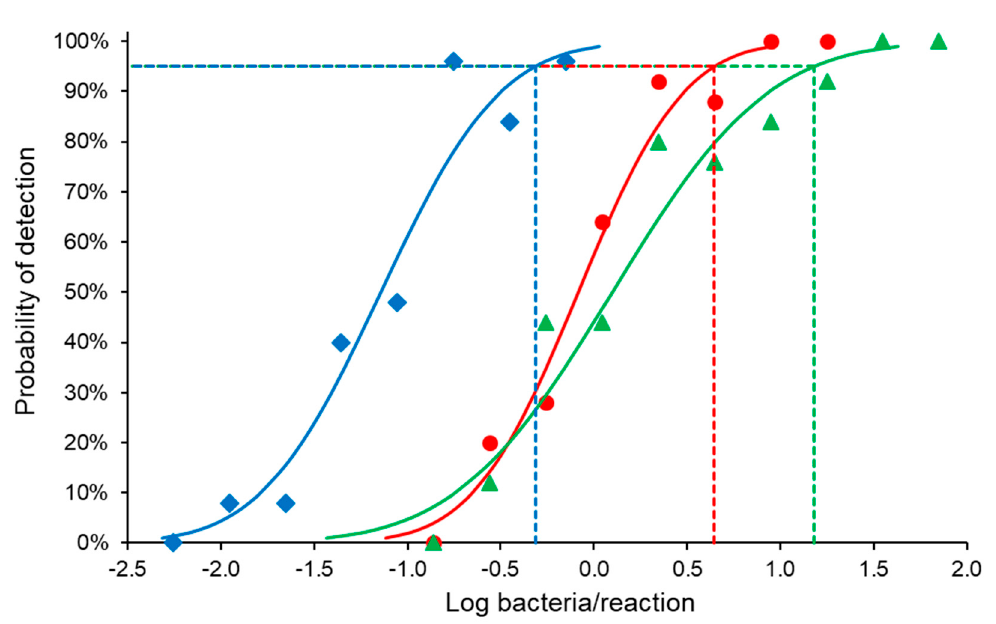
Figure 3. The 95% limit of detection (dotted lines) of a genus-specific 16S-23S rDNA internal transcribed spacer Brucella spp. PCR for tissue (diamond), blood (circle), and milk (triangle). One bacterium contains three copies of the 16S-23S rDNA internal transcribed spacer gene. Table 4. The 95% limit of detection of a genus-specific 16S-23S rDNA internal transcribed spacer (ITS) Brucella spp. PCR determined by probit analysis. CI—confidence interval. One bacterium is equivalent to three genome copies.